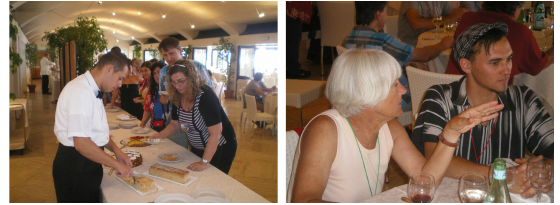
Figure 8: The delicious desserts served after the meals surely contributed to the workshop success as well.